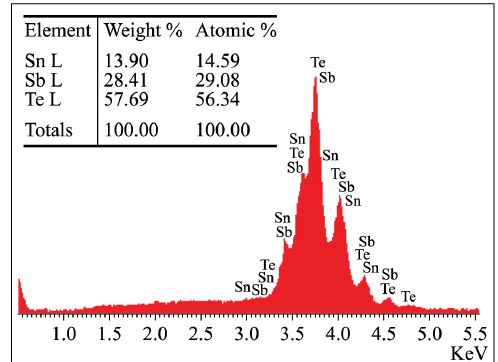
Figure 4. (color online) EDS results of chemical composition point ⊗ in the right picture of Figure 3. The inset shows the microanalysis data of SnSb Te microplatelets after 4 hours of milling. 2 4